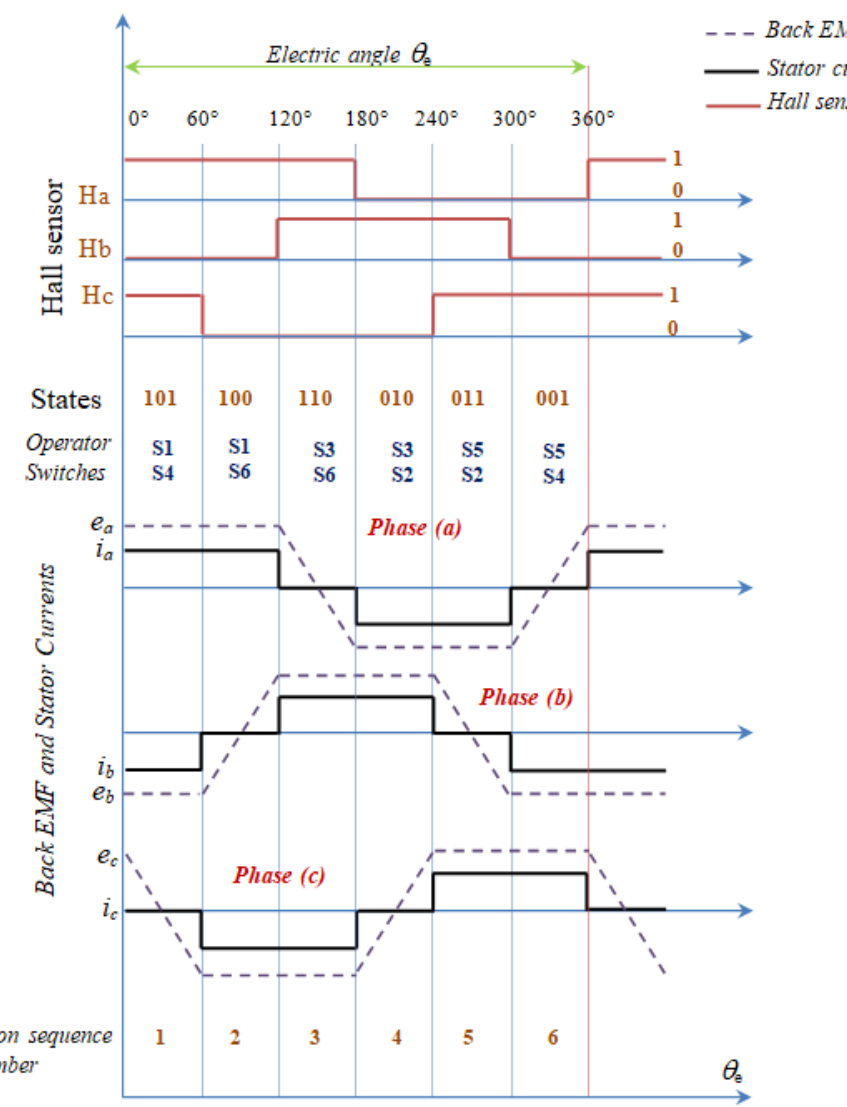
Figure 7. State of Hall sensor signals, Back-EMF and currents